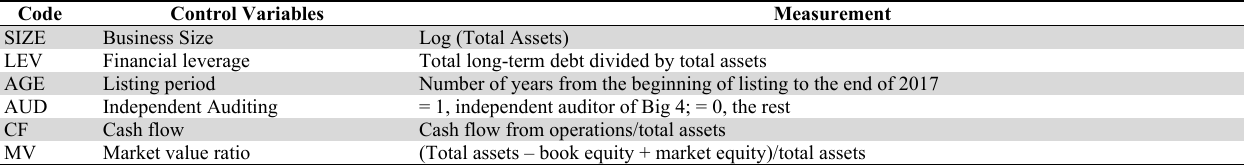
Control variable